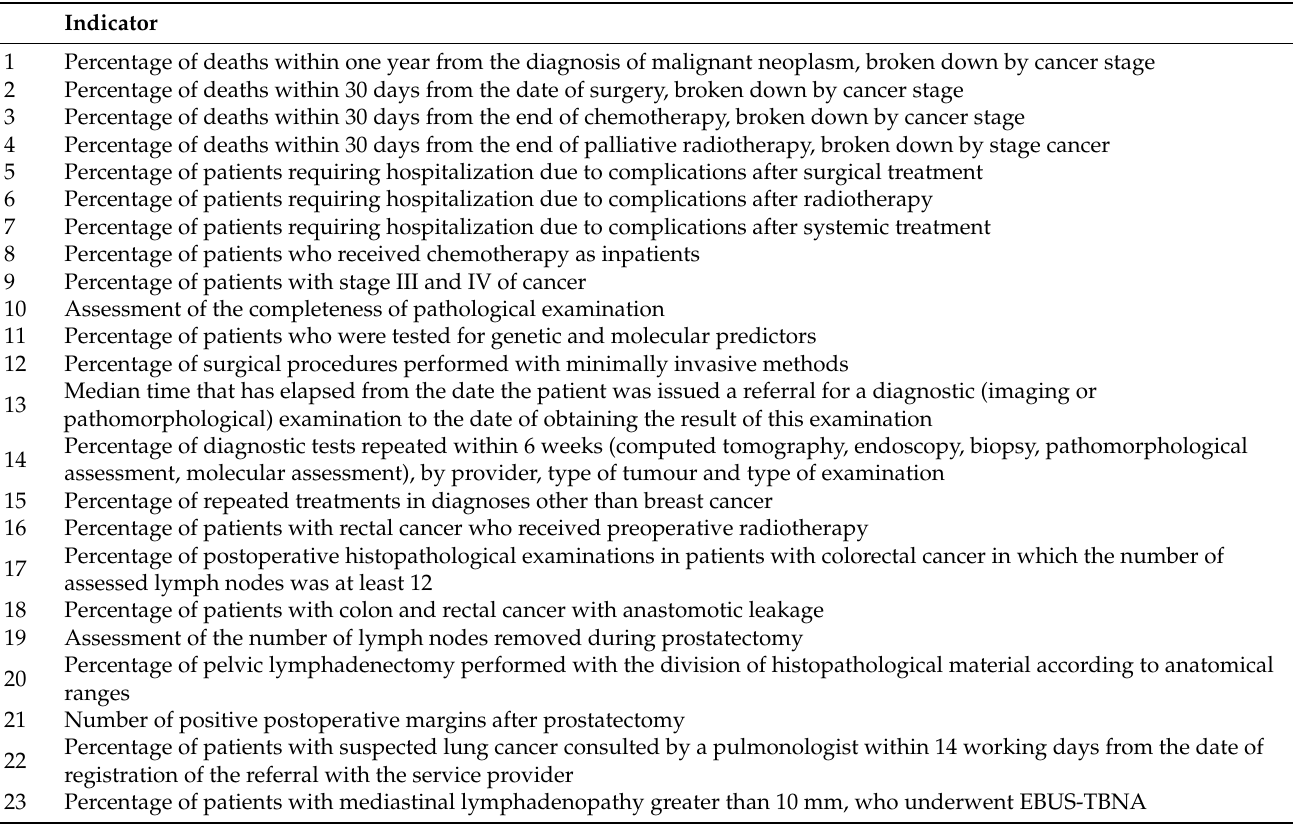
Table A1. Quality indicators monitored in the National Oncology Network pilots,